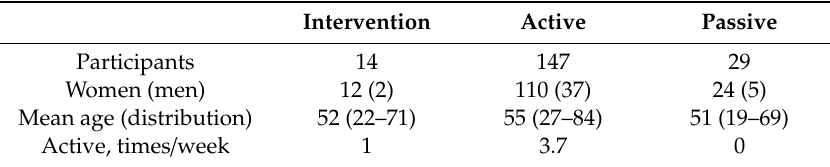
Table 1. Description of participants in the study divided by intervention group ( n = 14) and control group; active ( n = 147) and passive ( n =